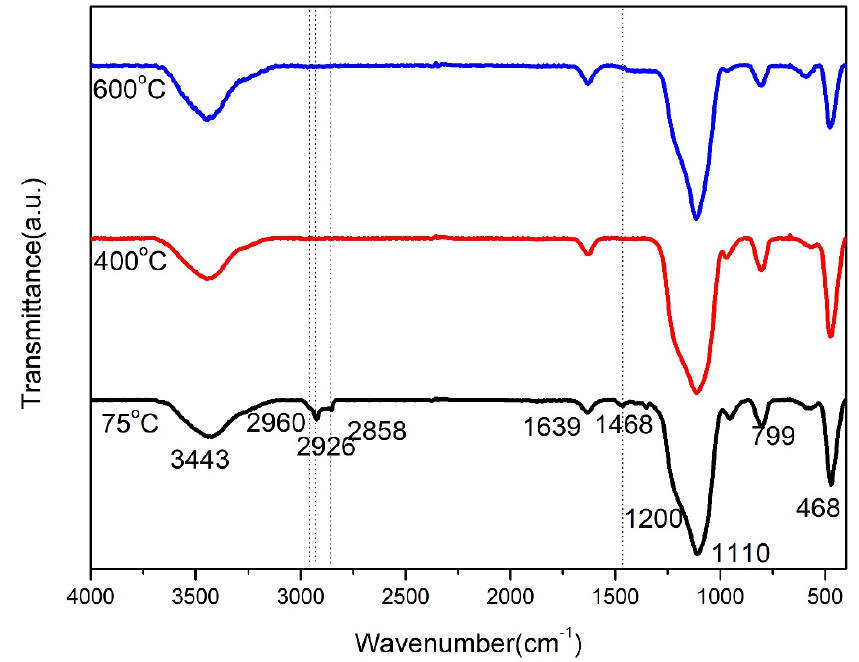
Figure 4. FTIR spectra of PEG ‐ 1 silica xerogels heat ‐ treated at different temperatures.